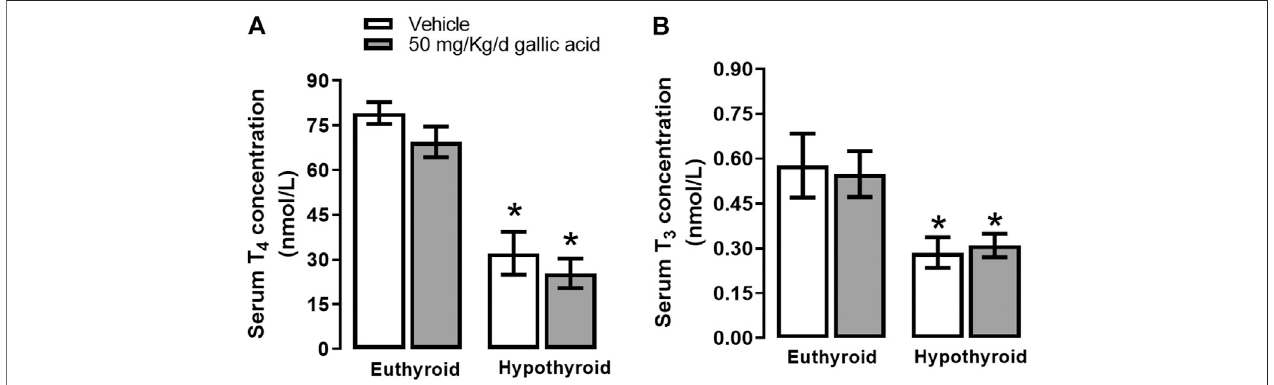
FIGURE 1 | Effect of gallic acid on thyroid hormone concentration. Values represent the mean ± SEM. (*) p < 0.05 vs. Euthyroid group same treatment group.